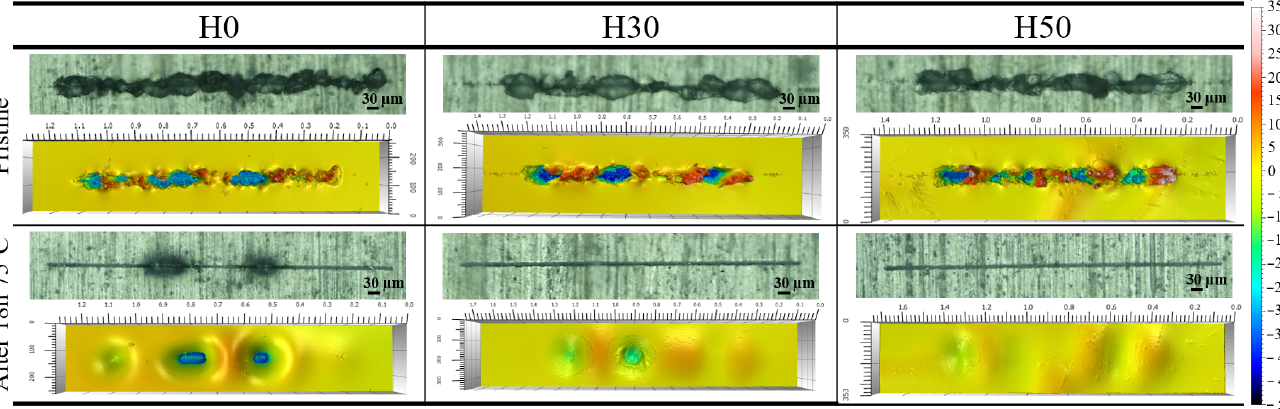
Figure 10. Optical and interferometric surface analysis results of scratched coatings before and after 18 h at 75 °C.